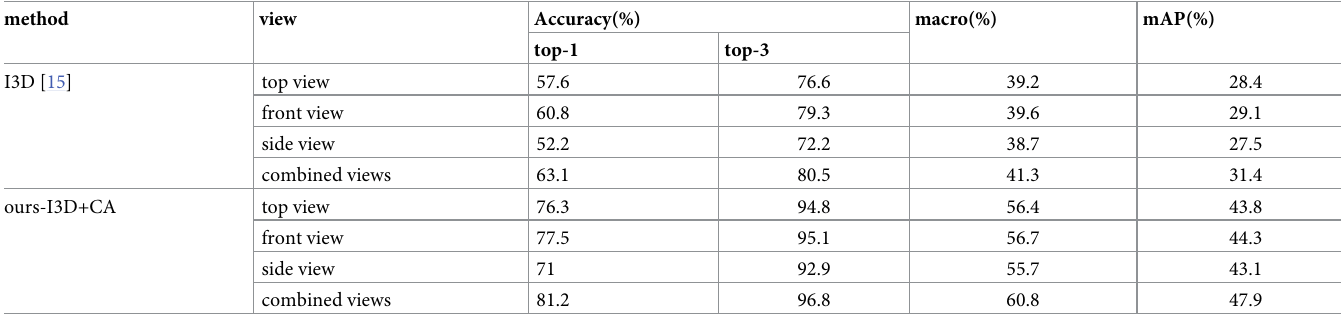
Table 5. Ablation study of action recognition on IKEA ASM dataset.